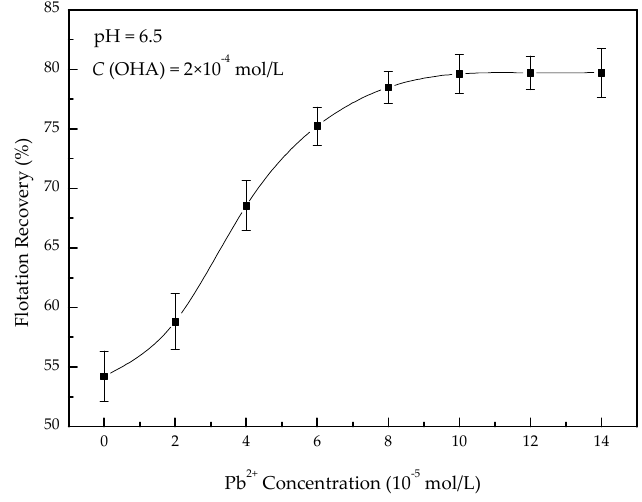
Figure 3. Effects of Pb 2+ concentration on perovskite flotation recovery. Minerals 2018 , 11 , x FOR PEER REVIEW